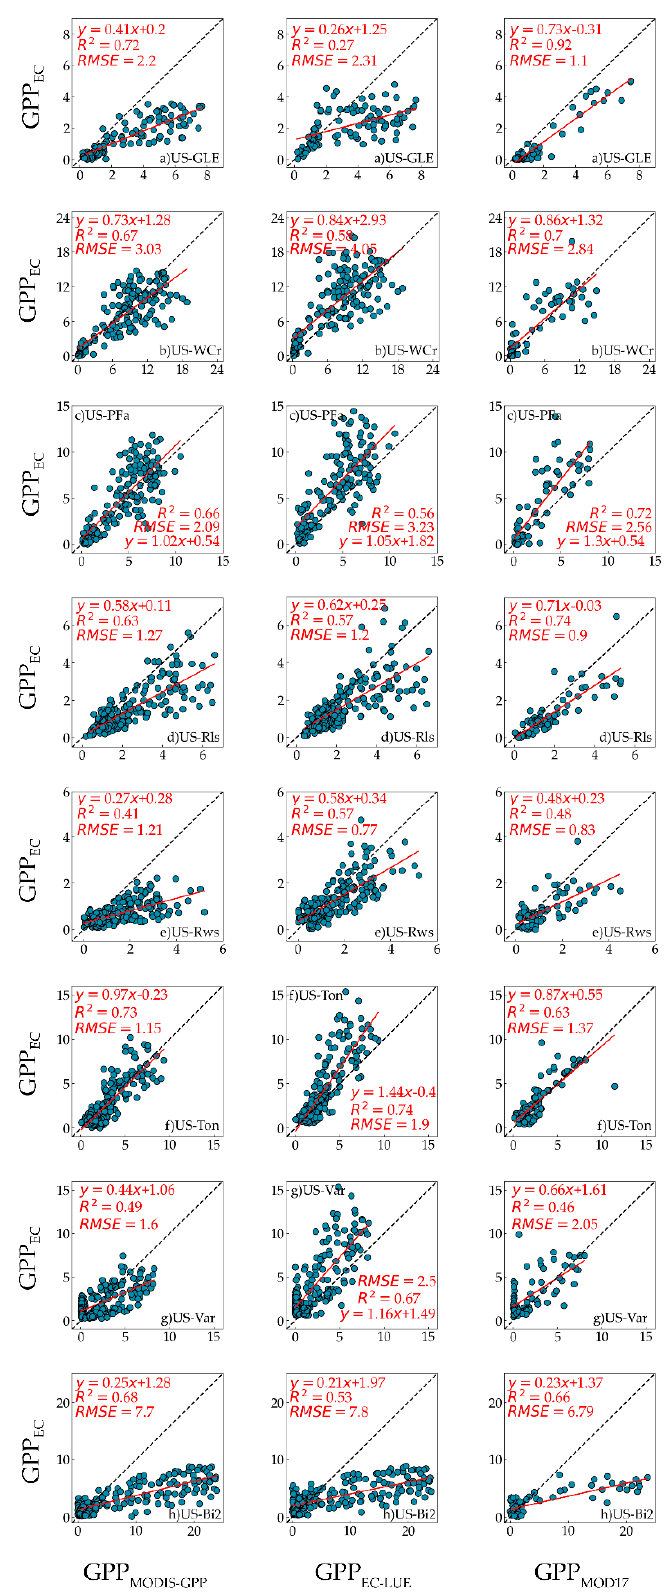
Figure 3. Scatter plots between GPP MODISGPP , GPP EC-LUE , GPP MOD17, and GPP EC for all sites in 2017–2018. The left column refers to the MODIS-GPP model, the middle column represents the EC-LUE model, and the right column represents the MODIS-GPP products.